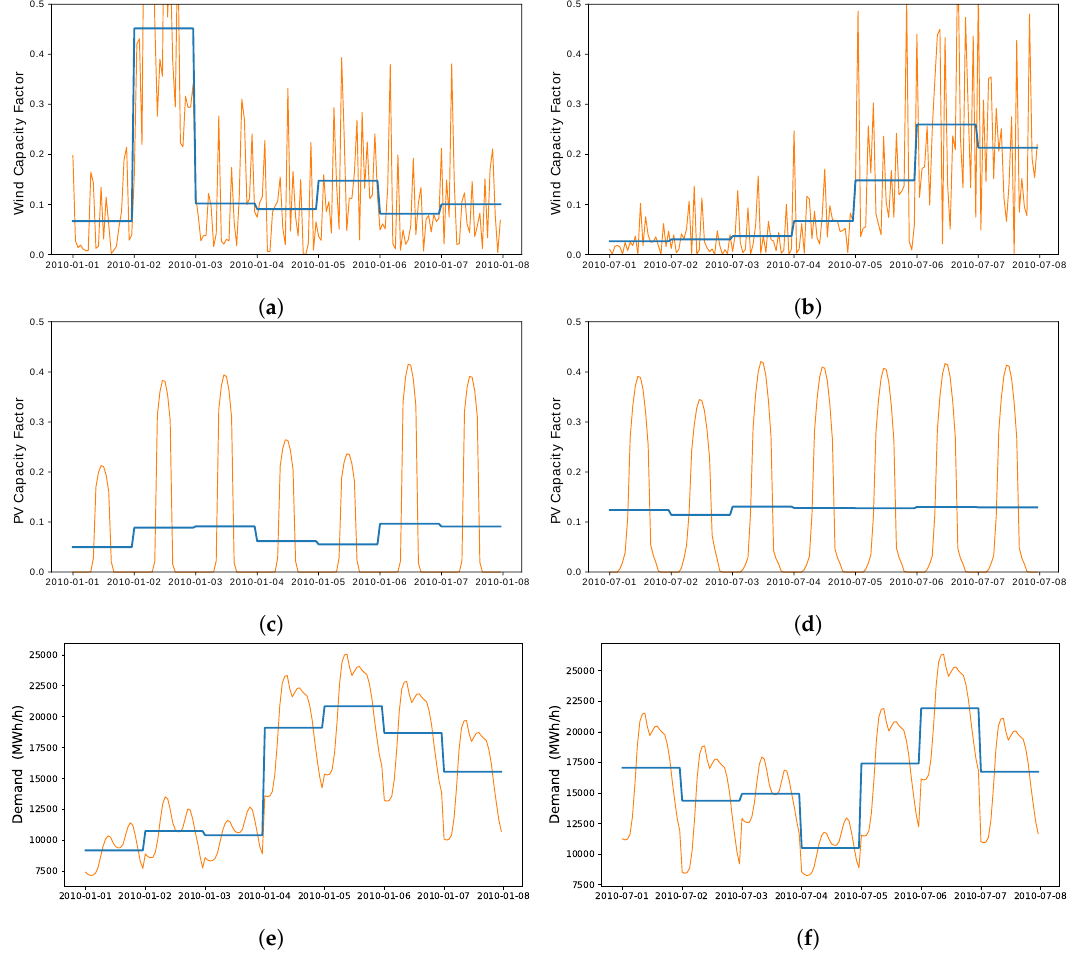
Figure A2. Hourly (orange) and daily mean (blue) wind capacity factor ( a , b ), PV capacity factor ( c , d ) and electricity demand ( e , f ) for the NORD zone, the first week of January (left) and of July (right) 2010. The data is predicted from the daily mean CORDEX data with the models and intra-day parametrizations described in Appendix